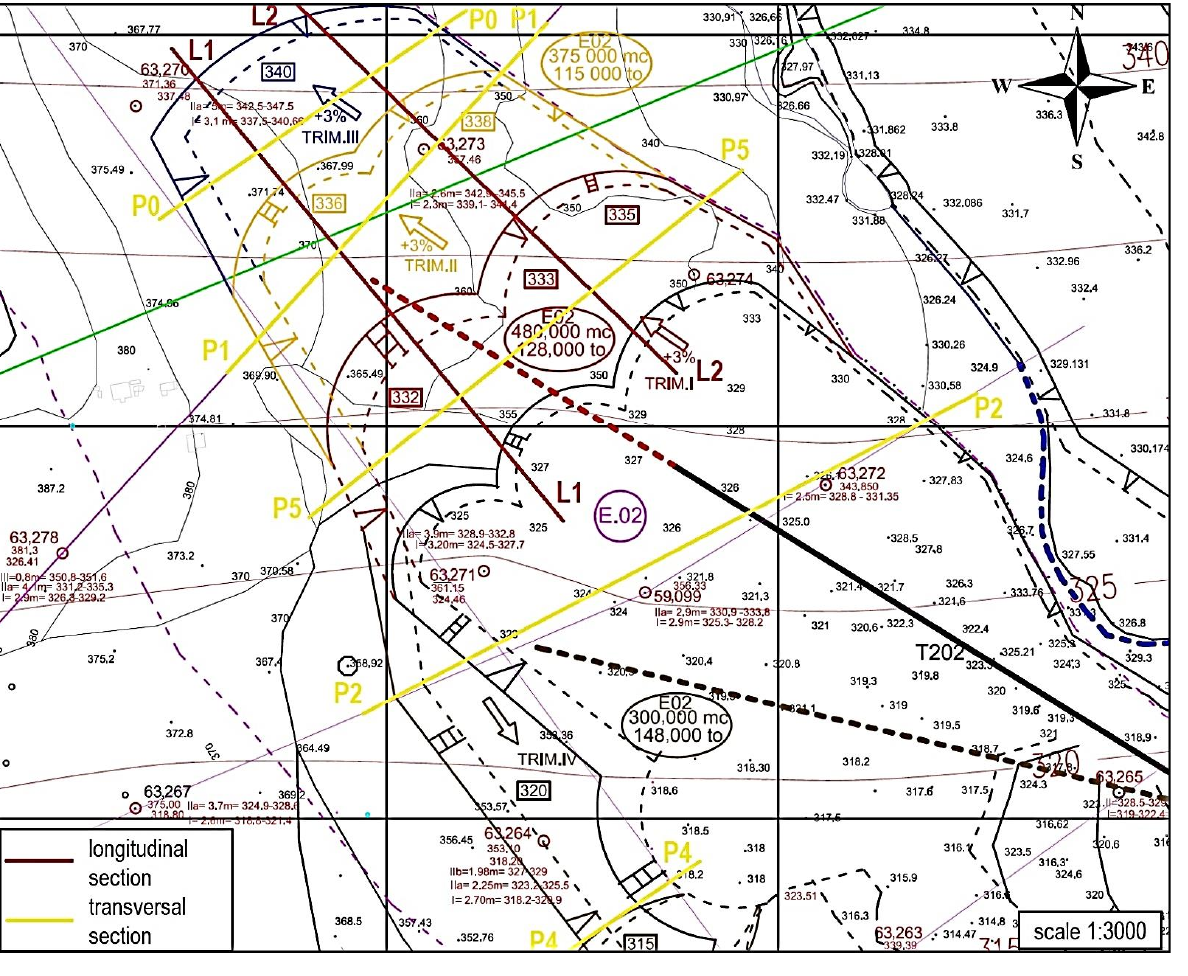
Figure 6. Evolution of Olte ț u open pit and the longitudinal and cross sections [56].